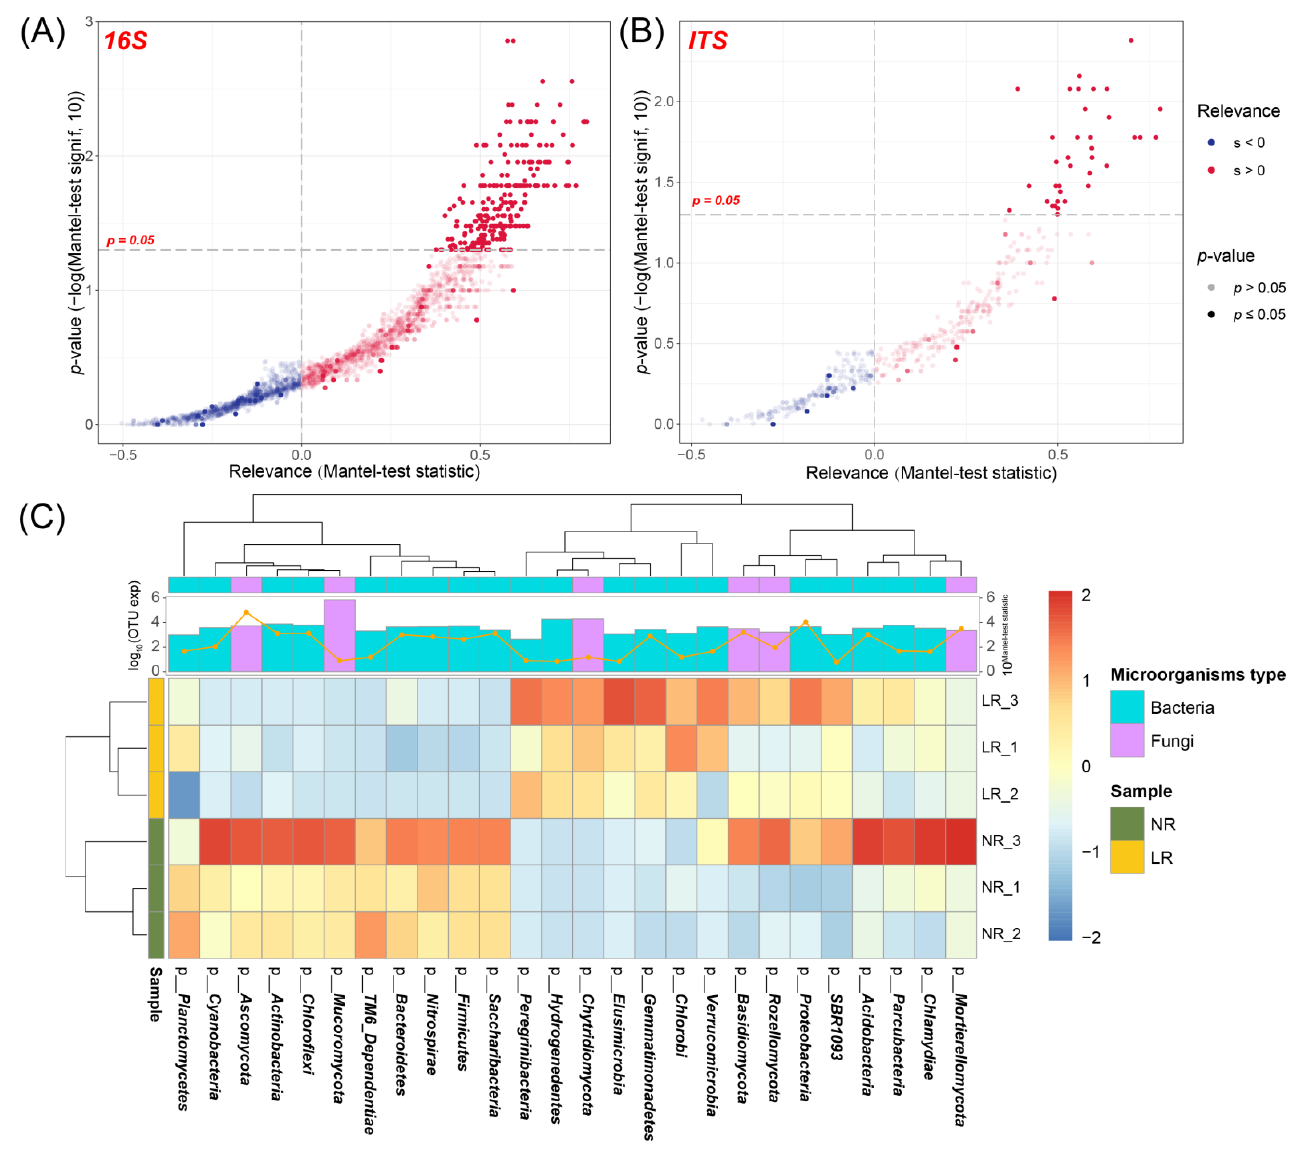
Figure 9. Identification of microorganism taxa related to root metabolome. NR- rhizosphere soil of normally growing plants; LR- rhizosphere soil of plants with limited growth. ( A ) Scatter plot of bacterial taxa related to the root metabolome data. ( B ) Scatter plot of fungal taxa related to the root metabolome data. ( C ) The heat map relating the abundance of bacteria and fungi to the root metabolome. The values in the middle heat map are the Z values of the relative abundance of bacteria or fungi in each row after standardization.